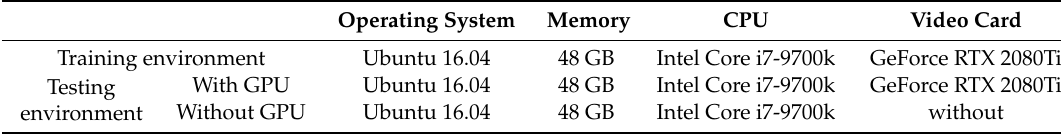
Table 2. Hardware environment configuration information.